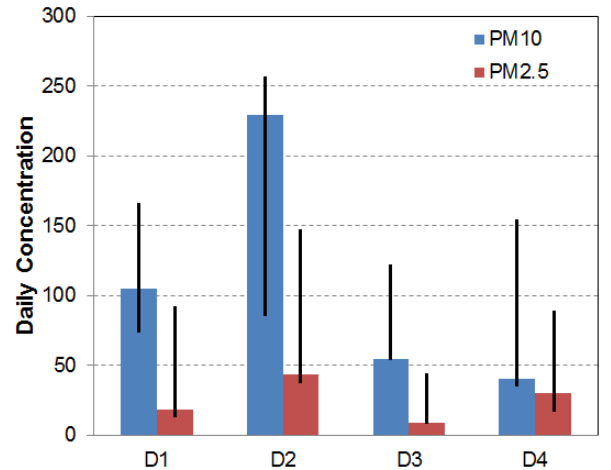
Figure 2. Daily average concentrations of PM 10 and PM 2 . 5 on dust storm days. Data from sites in dust-storm-impacted regions for four typical events are from the IMPROVE network and the EPA AQS data set. Statistical ranges of ratios for each type are shown by black lines. The analysis is based on the measurements from the AQS site within the dust-storm-impacted area. D1: AQS records for event type 1 (site 480290053 for typical event); D2: AQS records for event type 2 (site PHOE1 for typical event); D3: AQS records for event type 3 (site SAGO1 for typical event); D4: AQS records for event type 4 (site WIMO1 for typical event). (Unit: µgm − 3 .)